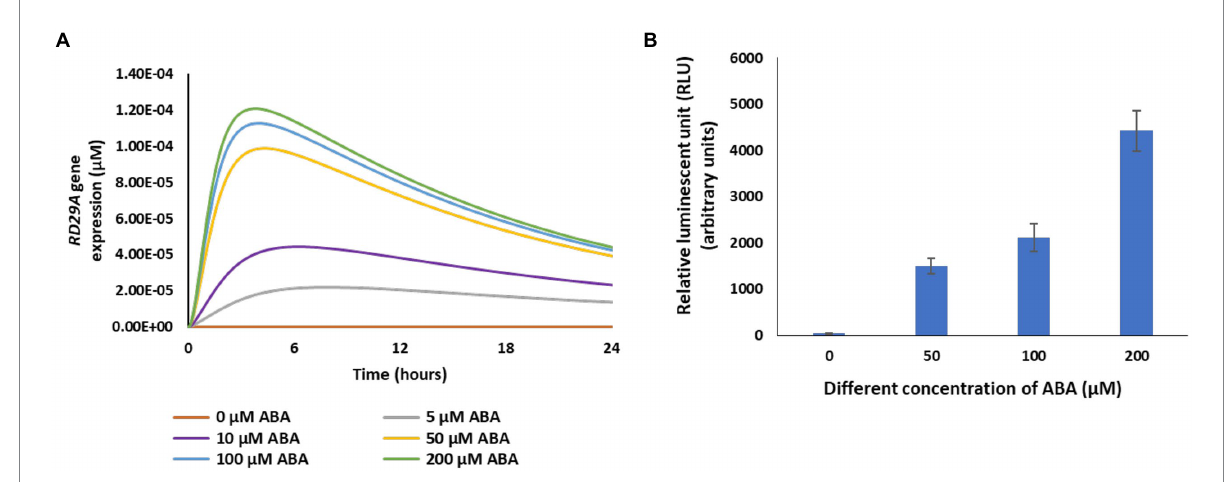
FIGURE 4 RD29A expression increases with a function of ABA concentration in the model as it is observed in actual plants. (A) Model output of the variable RD29A with different values of the variable ABA. (B) The relative luminescence unit in 25-day-old RD29A::LUC plants was determined at 5 h after spraying different concentrations of ABA. The bars represent the mean relative luminescence of three replicates, with error bars representing standard error from the mean (15 seedlings).